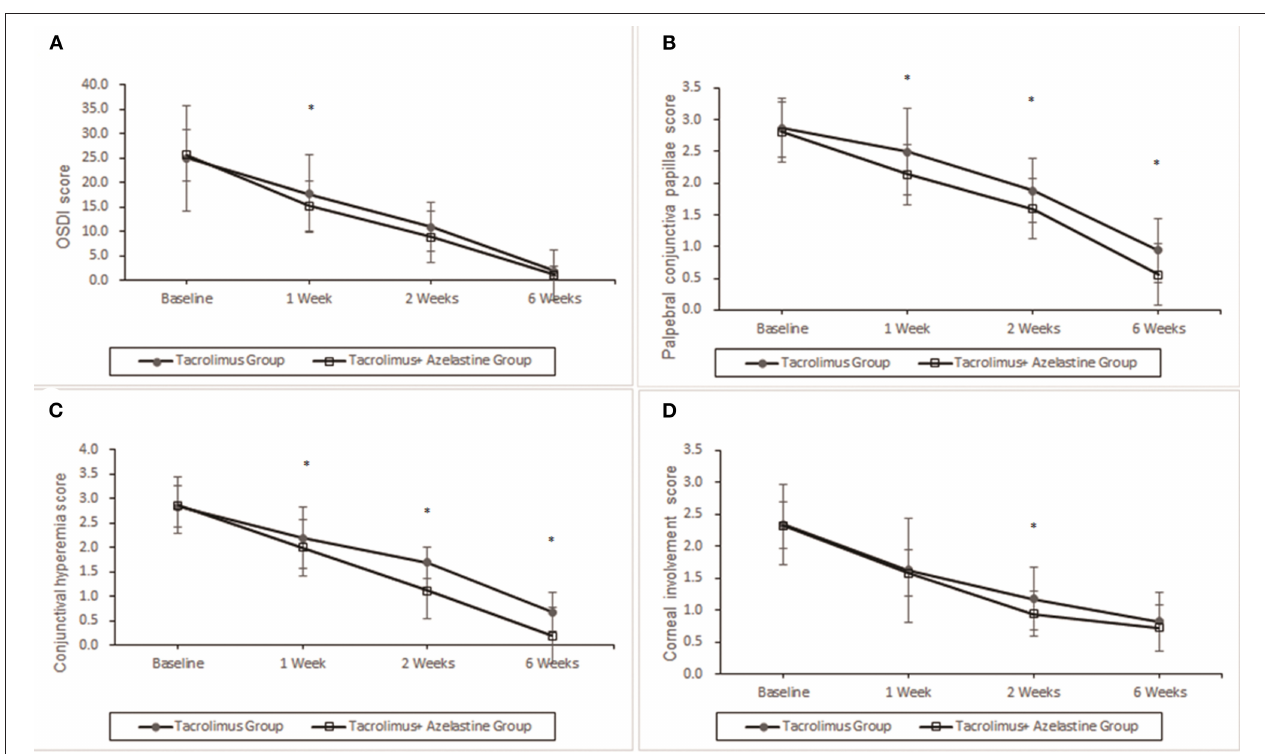
FIGURE 2 | Improvement of OSDI symptoms, conjunctival hyperemia, corneal involvement and palpebral conjunctiva papillae by 0.1% topical tacrolimus eye drops alone or with 0.05% azelastine from baseline. (A) The OSDI score was significantly improved at 1, 2, and 6 weeks in both groups ( p < 0.0001). Significant additive effect was observed with adjunctive topical 0.05% azelastine use at 1 week after therapy ( p = 0.0085). (B) and (C) Patients treated with combined medicine have a significant beneficial effect compared with patients treated with tacrolimus alone at 1, 2, and 6 weeks in conjunctival hyperemia and palpebral conjunctiva papillae